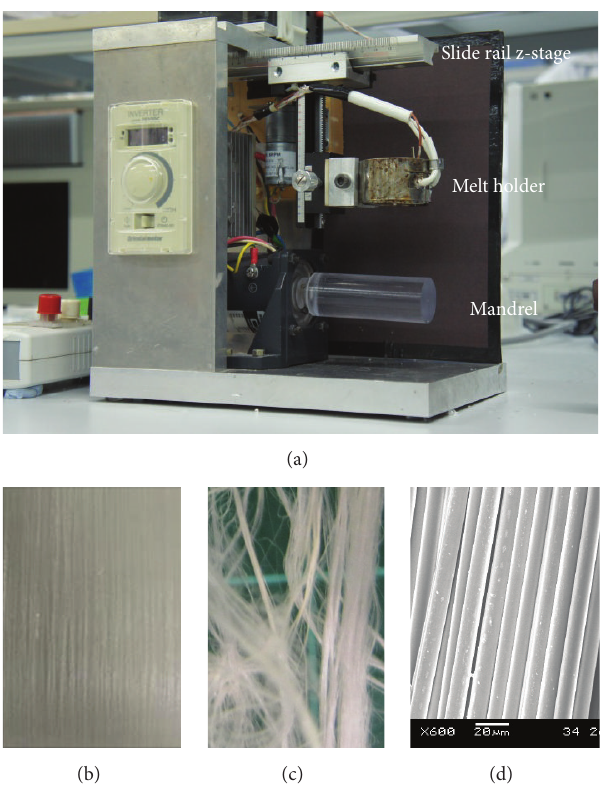
Figure 1: Melt spinning apparatus depositing fiber on a turning mandrel, demonstrating the slide rail, z-stage, melt holder, and mandrel;formoredetailsseeAnetal.[21](a).SEMimageofthePCL fiber removed from the mandrel (b). PCL fibers without adhesive to maintain alignment (c), PCL fibers adhered into aligned orientation, using chitosan solution as an adhesive